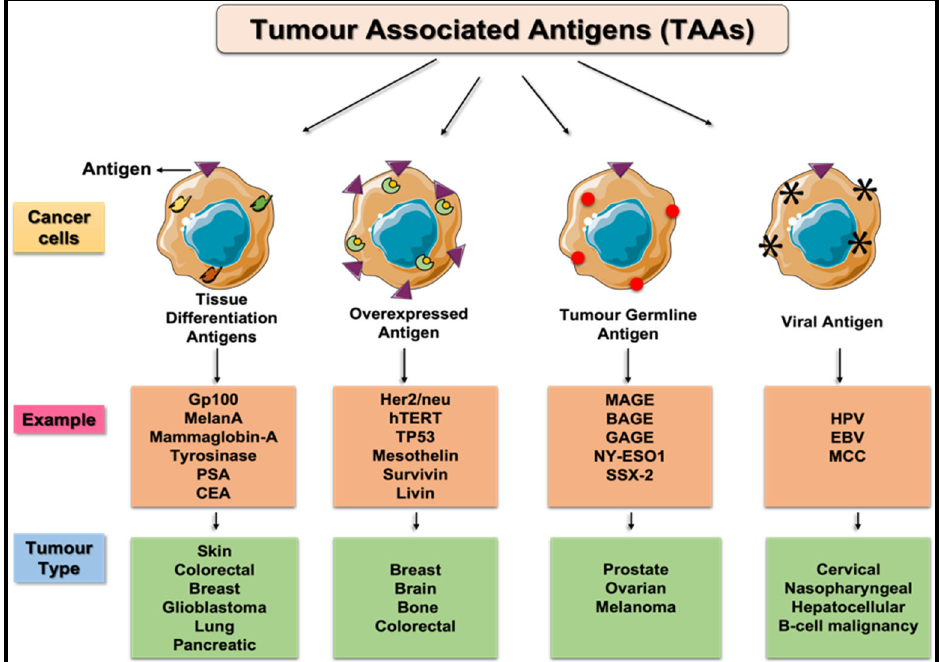
Figure 2. Tumor associated antigens and its expression pattern.